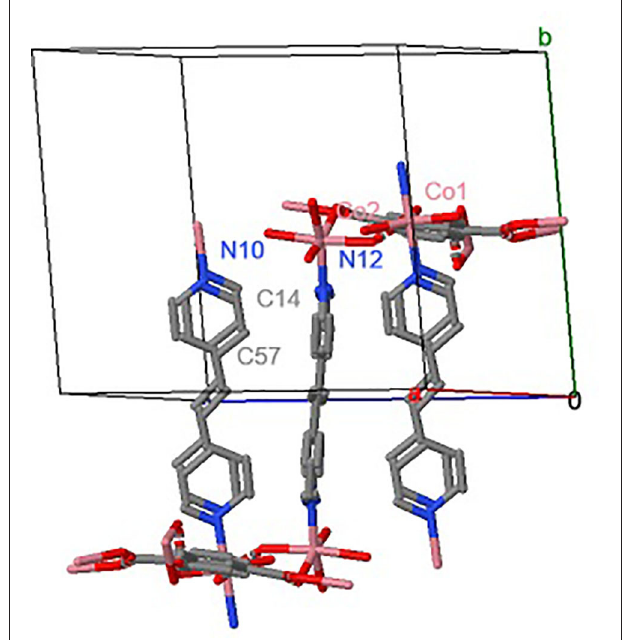
FIGURE 1 | MOF UV-11 unit cell